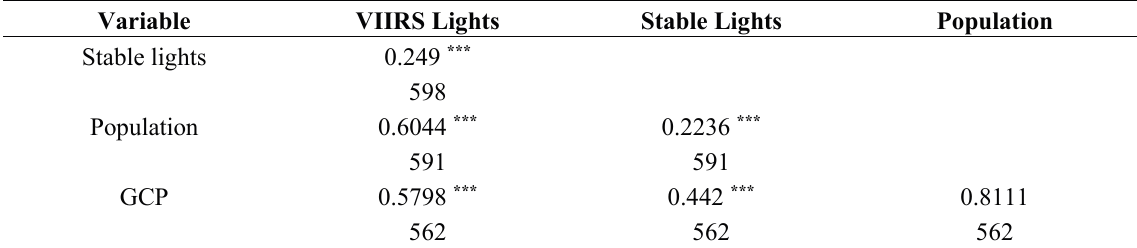
Table 4. Pairwise correlations for cells with population less than 10,000 ( *** p < 0.001).